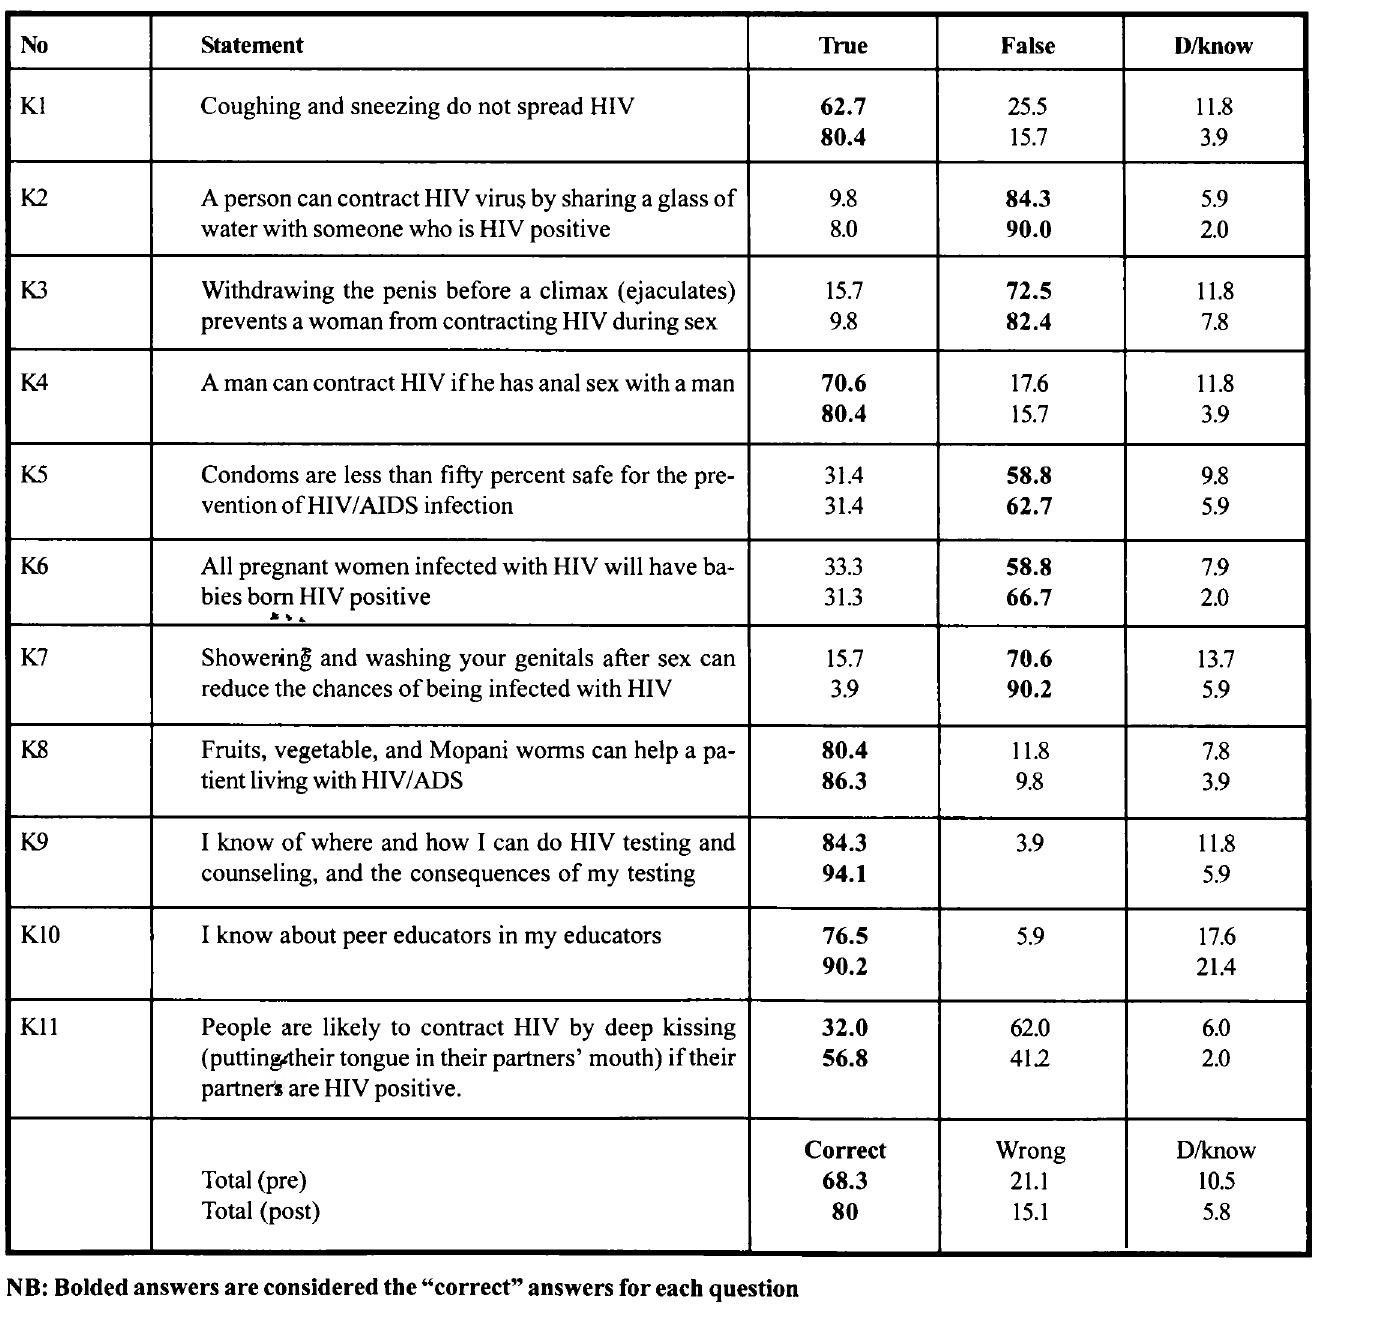
Table 3: Percentage response on HIV/AIDS knowledge, before and after HIV/AIDS awareness